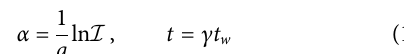
Frontiers in Applied Mathematics and Statistics |